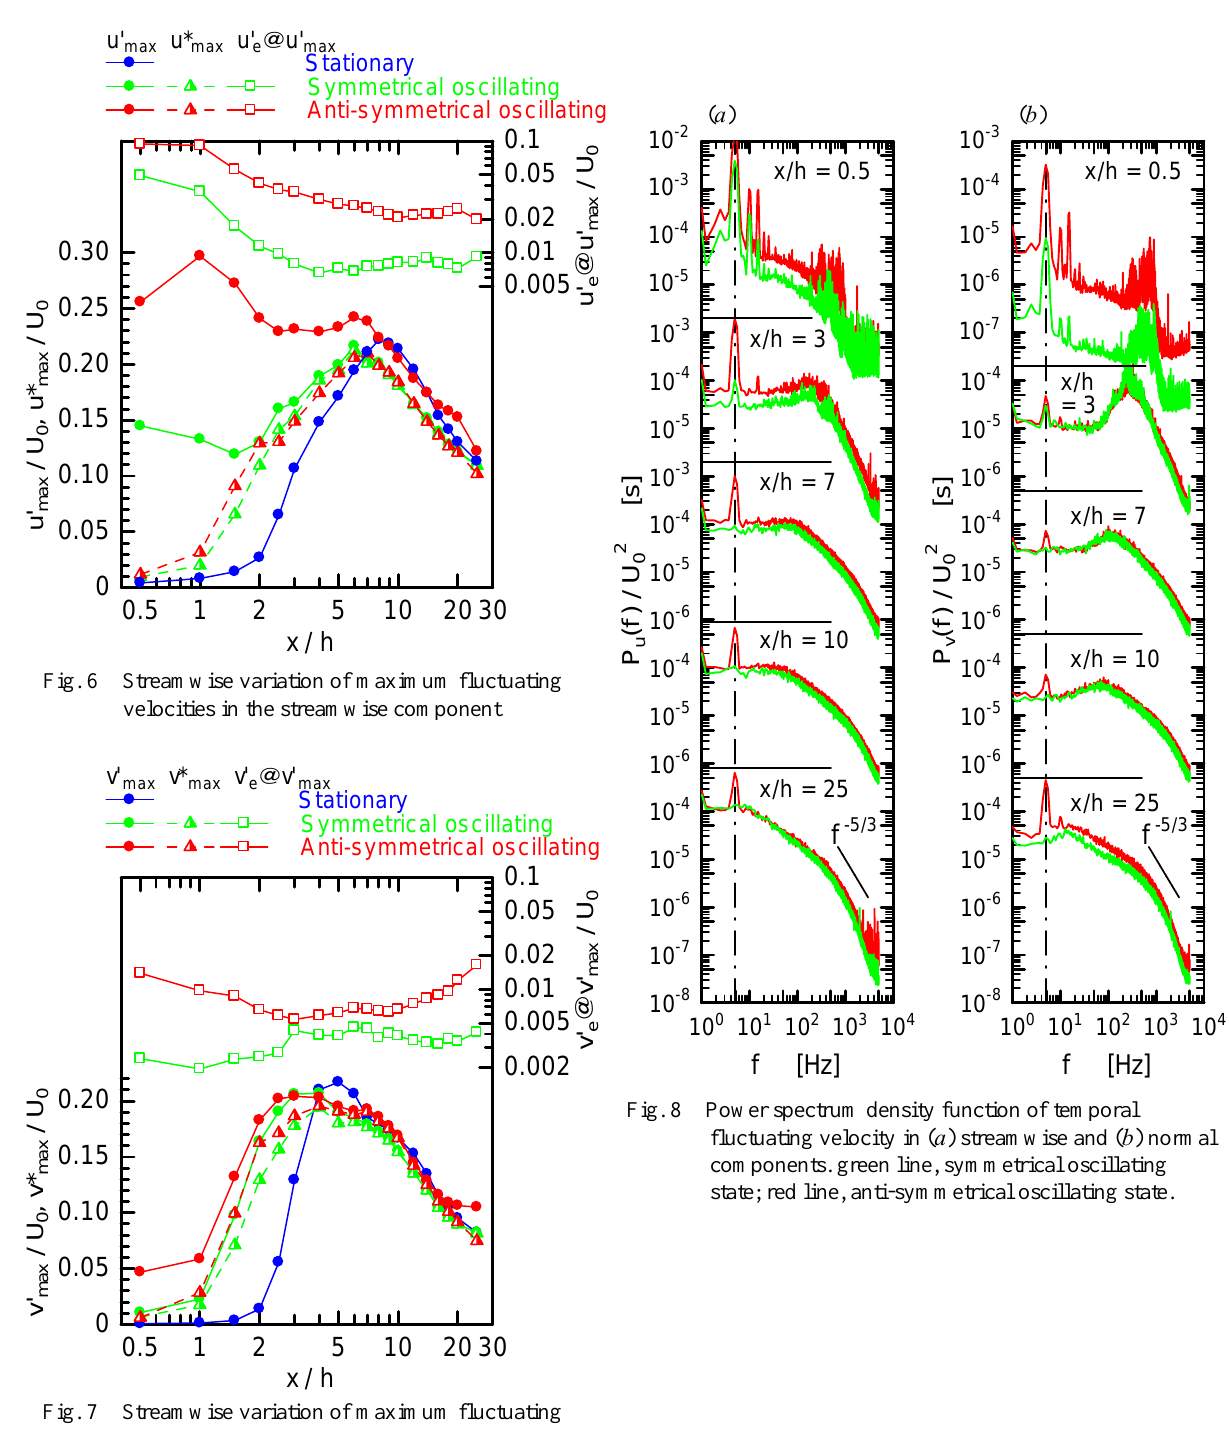
Fig. 7 Streamwise variation of maximum fluctuati velocities in the normal component